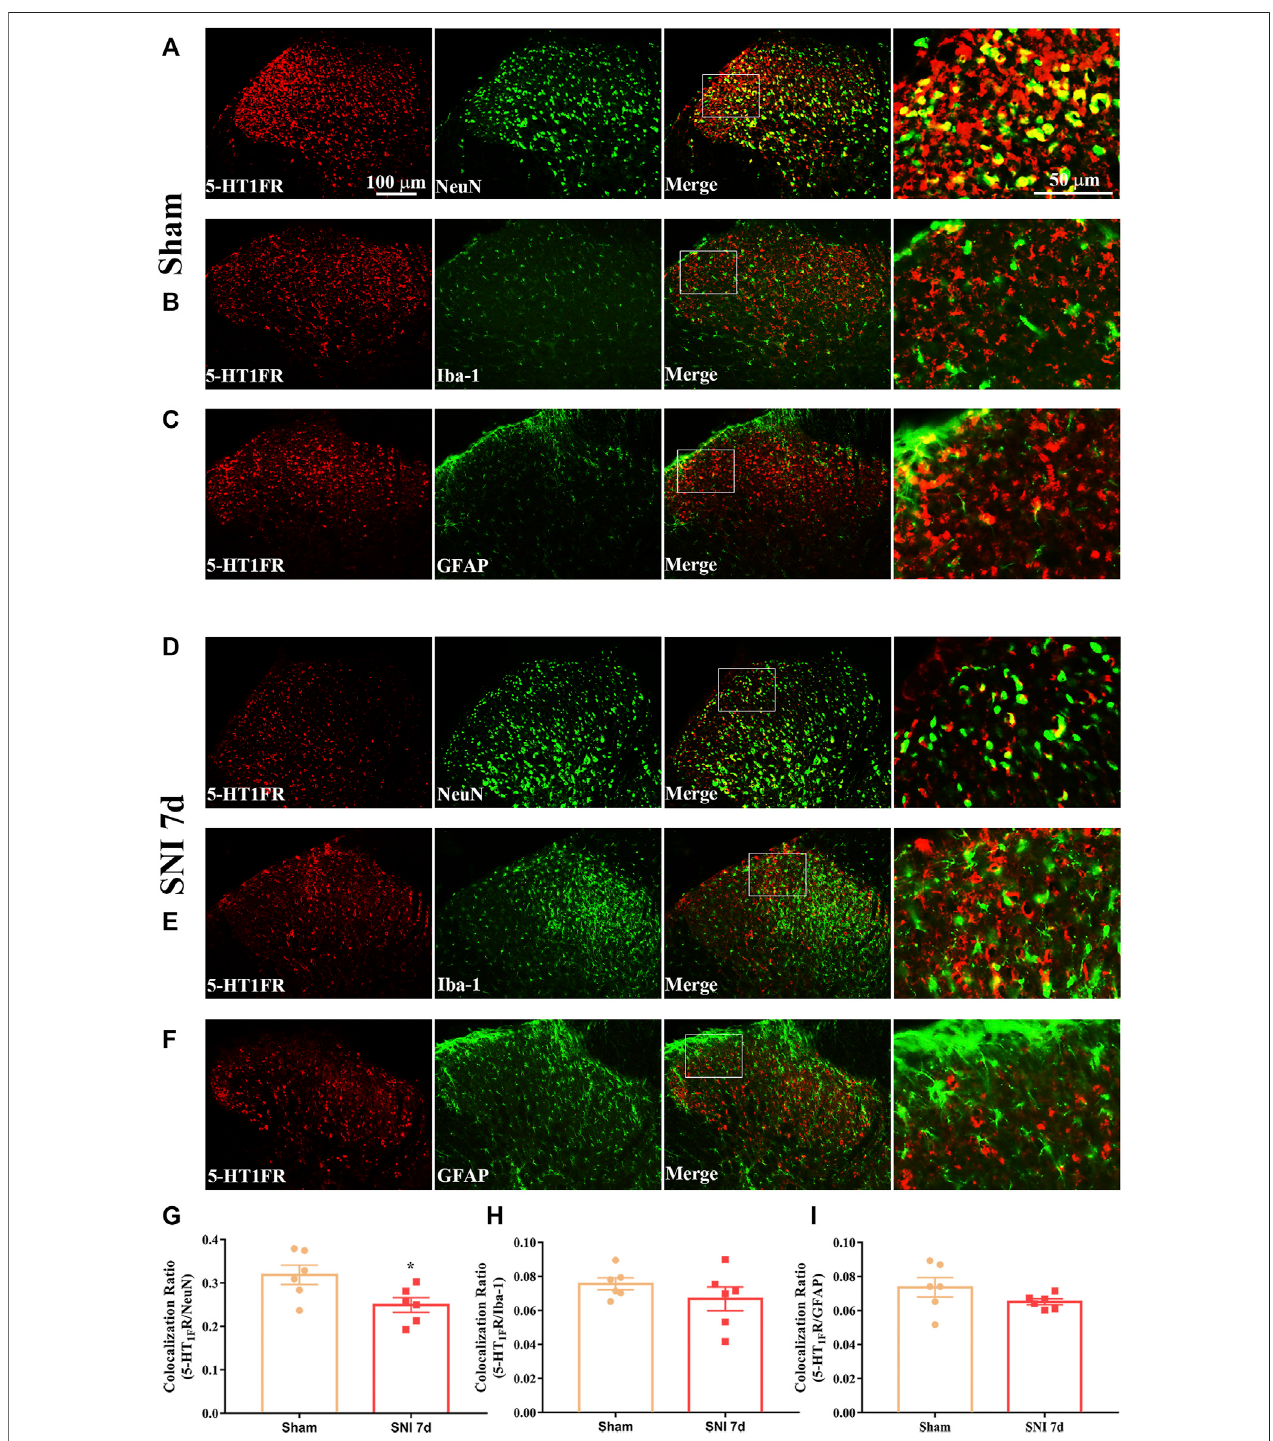
FIGURE 4 | Double immuno fl uorescence of 5-HT 1F receptor and NeuN, GFAP, and Iba1 in the spinal cord of sham and neuropathic pain rats. (A) Double immuno fl uorescence of 5-HT 1F receptor and NeuN in the spinal cord of sham rats. (B) Double immuno fl uorescence of 5-HT 1F receptor and Iba-1 in the spinal cord of shamrats. (C) Doubleimmuno fl uorescenceof5-HT 1F receptorandGFAPinthespinalcordofshamrats. (D) Doubleimmuno fl uorescenceof5-HT 1F receptorandNeuN inthespinalcordofSNIrats. (E) Doubleimmuno fl uorescenceof5-HT 1F receptorandIba-1inthespinalcordofSNIrats. (F) Doubleimmuno fl uorescenceof5-HT 1F receptor and GFAP in the spinal cord of SNI rats. (G – I) Neuropathic pain induced decreased colocalization of 5-HT 1F receptor with neurons (NeuN), while the colocalization of 5-HT 1F receptor with astrocytes (GFAP), and microglia (Iba-1) remained sparse in the spinal cord (* p < 0.05 compared with sham group, n = 6 in each group).